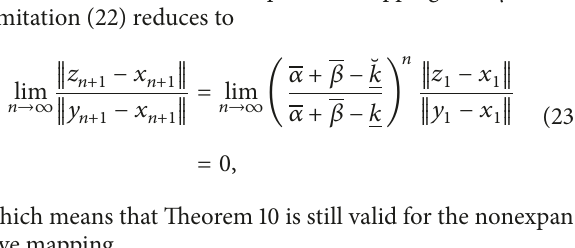
+ 𝑦 ))| < 0.5 , we can derive the following 𝑛 𝑛